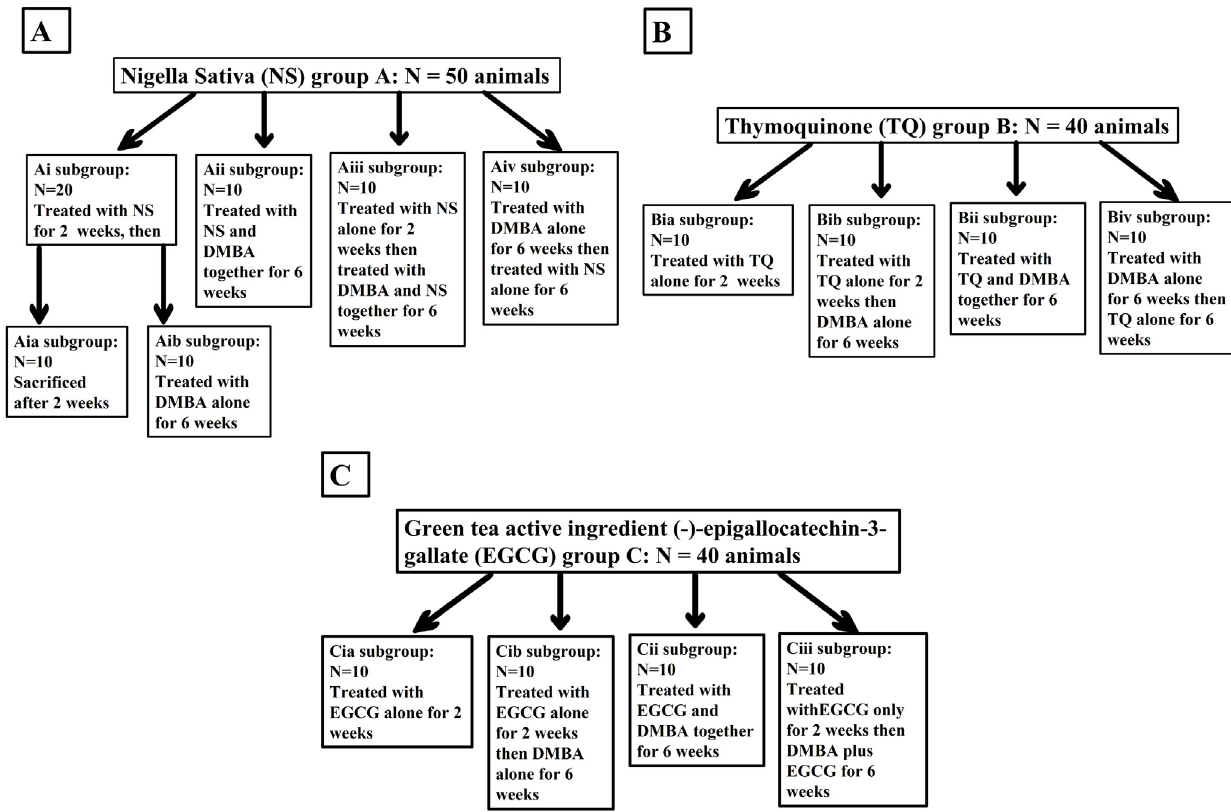
Fig. 1. Temporal scales A, B, and C explain the subdivisions, animals ’ numbers and phytochemical treatments which were given to subgroups of groups A, B, and C. Group A: 50 animals were treated with Nigella sativa (NS), Group B: 40 animals were treated with Thymoquinone (TQ), and Group C: 40 animals were treated with green tea active ingredient ( – )-EpiGalloCatechin-3-Gallate